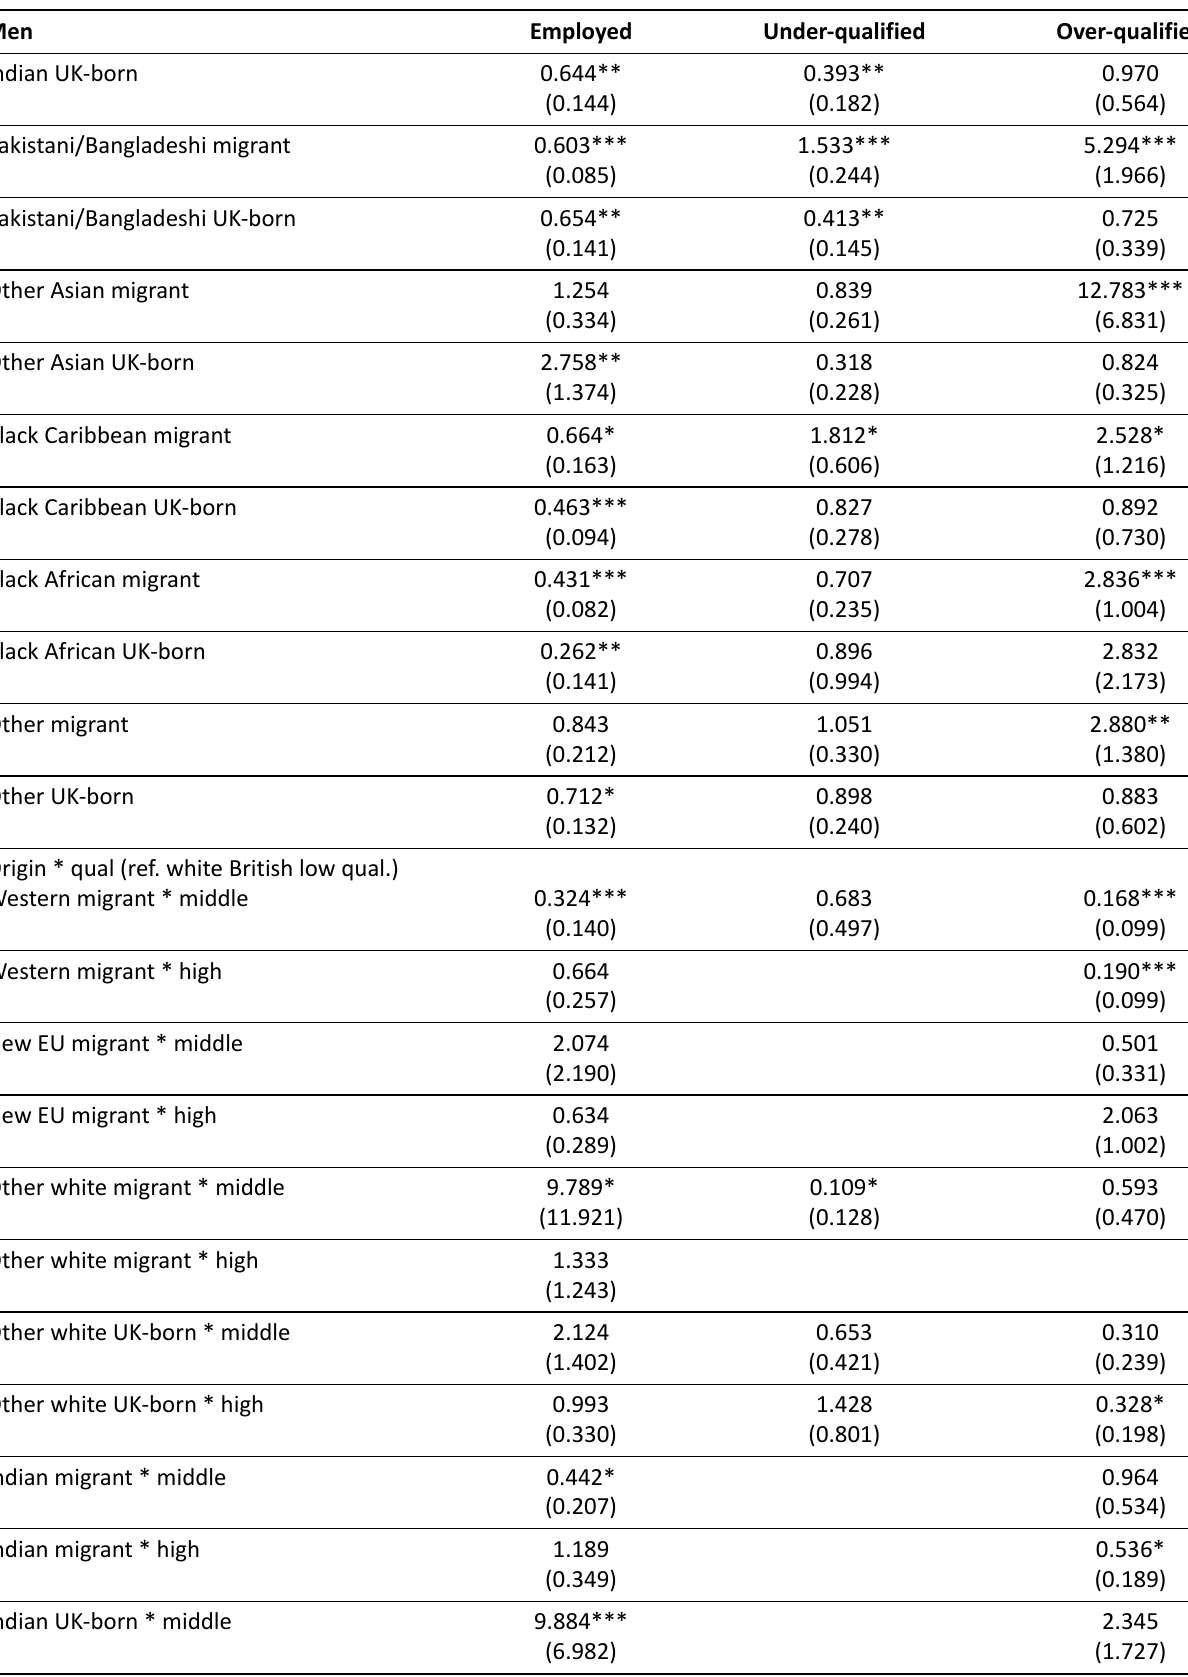
Table A3. (Cont.) Binary logistic regression model (odds ratio) of employment, under- and over-qualification for men. Men